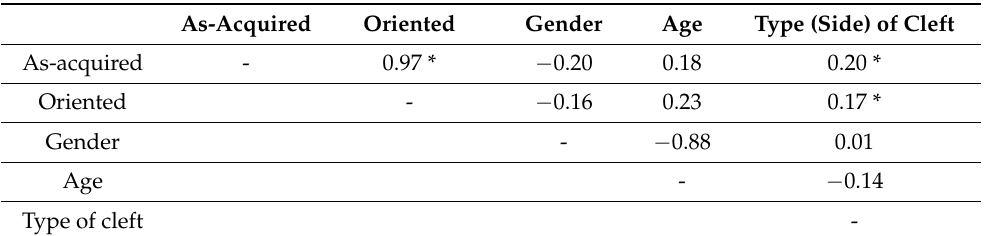
Table 2. Spearman’s correlation analyses of socio-demographic patterns and as-acquired and oriented